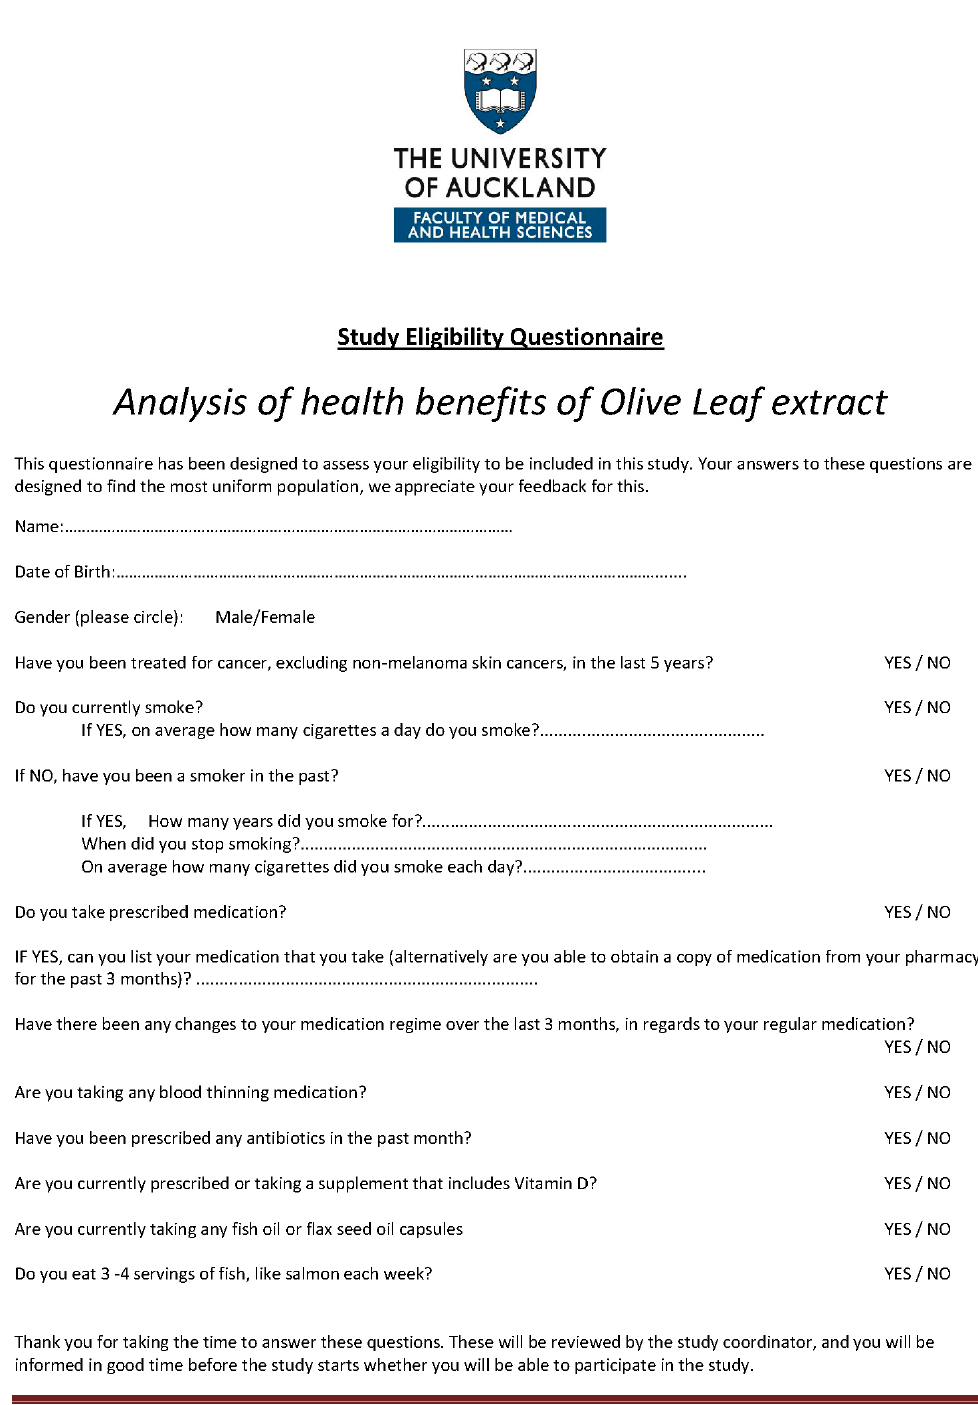
Figure A1. Eligibility question used to determine selection of the healthy study participants.